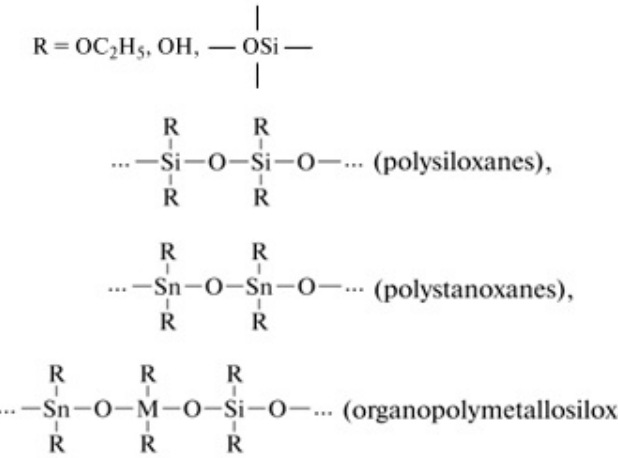
Figure 18. Examples of organoelement compounds.